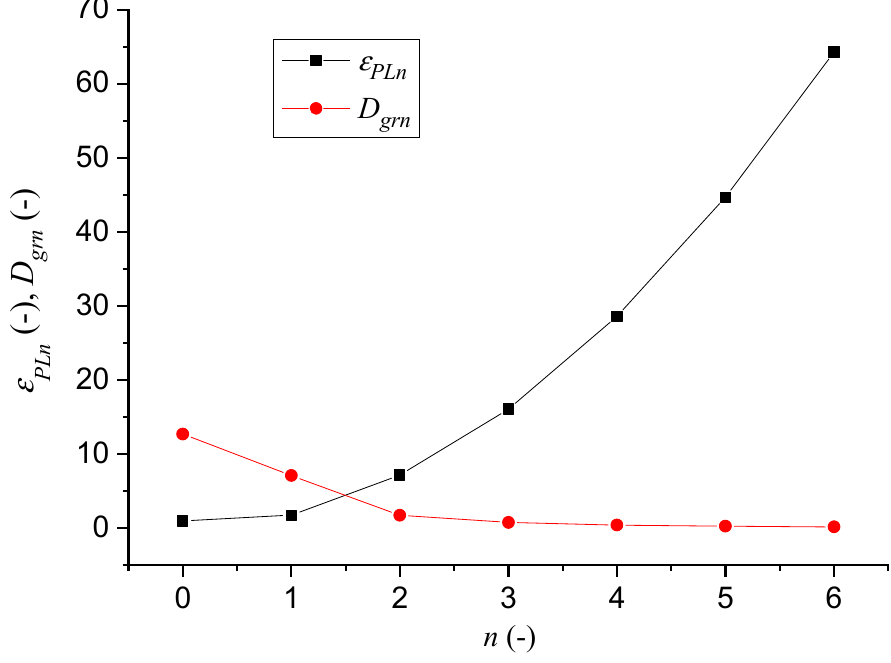
Figure 9. Calibration graphs of dependence ( ε PLn , D grn ) = f( n ) for n = 0, 1, 2, 3, 4, 5, 6.